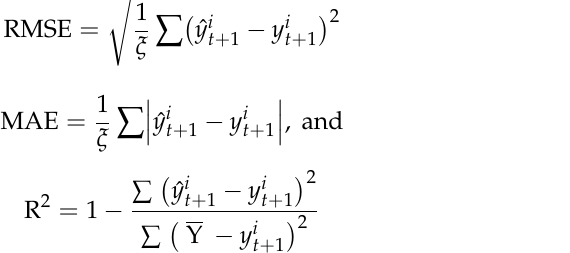
Figure 10. Computation of the geographic interactions of user movements. The user check-in sequences are constructed from their location records at different time intervals.